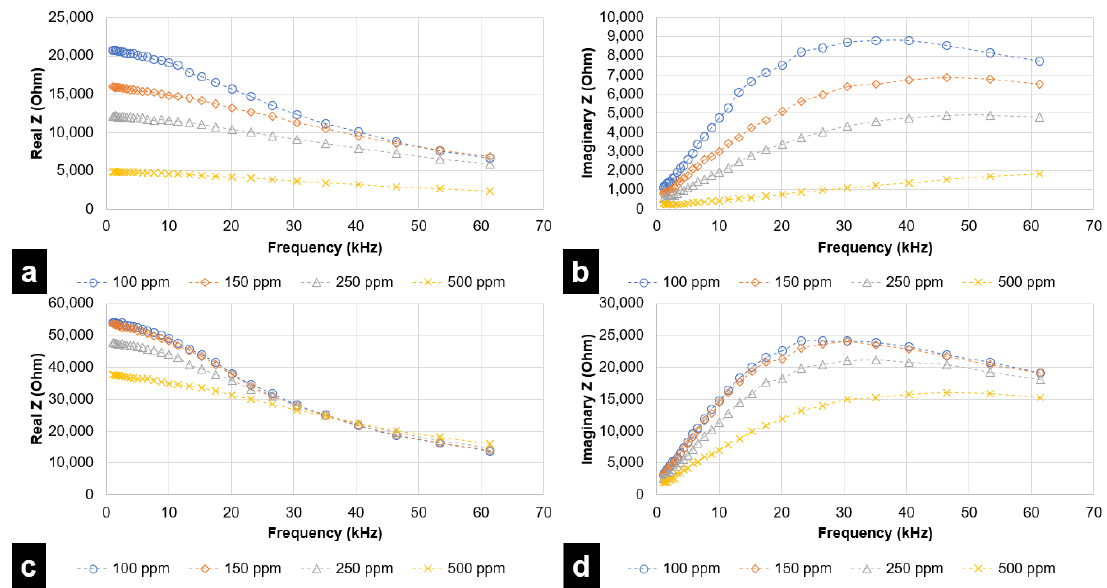
Figure 7. EIS analysis for Citric Acid (sour) and L-tryptophan (bitter), in the range of 1 kHz to 62 kHz, for inkjet printing- based IDE sensor in terms of ( a ) Resistive Impedance vs. Frequency (Citric Acid) ( b ) Reactive Impedance vs. Frequency (Citric Acid) ( c ) Resistive Impedance vs. Frequency (L-tryptophan) ( d ) Reactive Impedance vs. Frequency (L-tryptophan).